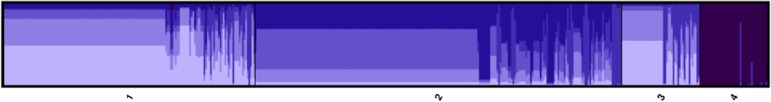
Population structure for grouping based on haplotype network constructed by using the statistical parsimony method for COI gene of Chrysoperla externa.Each individual is represented by a thin vertical line, which is partitioned into coloured segments that represent the individual’s probability of belonging to the cluster with that colour. Colors represent clusters (K), interpreted as mutational steps from an ancestral haplotype not present in the analysis.